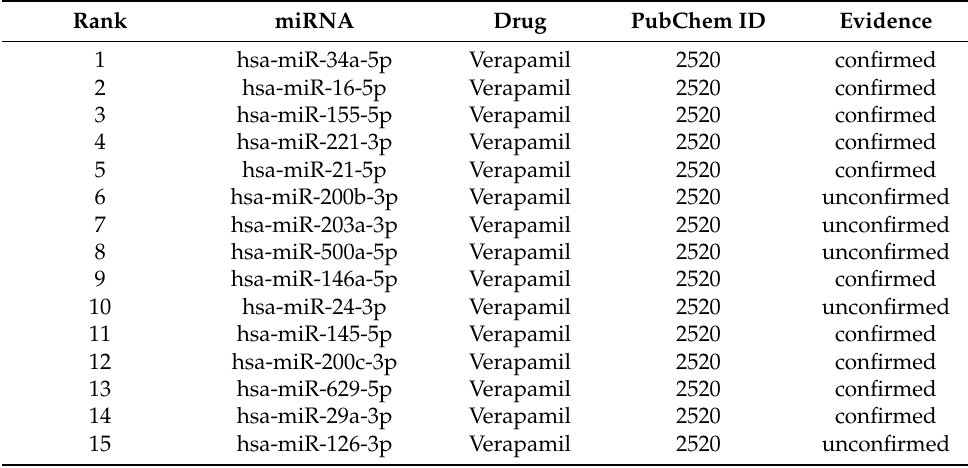
Table 8. The top 15 predicted miRNAs interacting with the